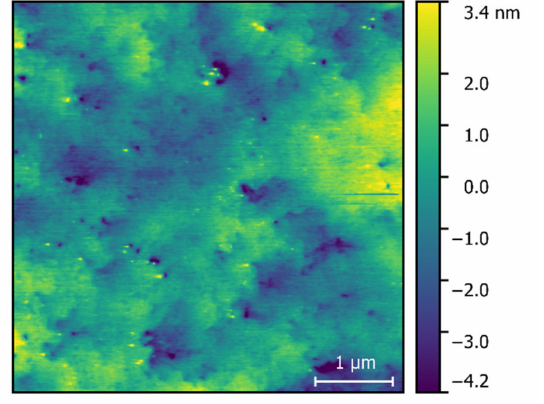
Figure 1. AFM image of the as-grown